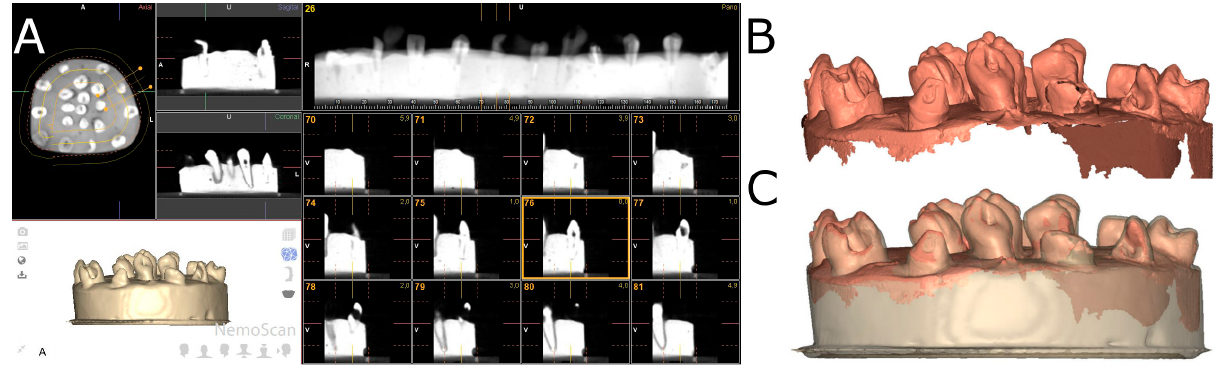
Figure 2. ( A ) CBCT scan, ( B ) STL digital files and ( C ) alignment of the digital workflow. After matching the 3D surface scan and CBCT data (WhiteFox), each tooth in the internal part of the model was individually segmented and virtually placed between the teeth placed outside of the model (Figure 3).